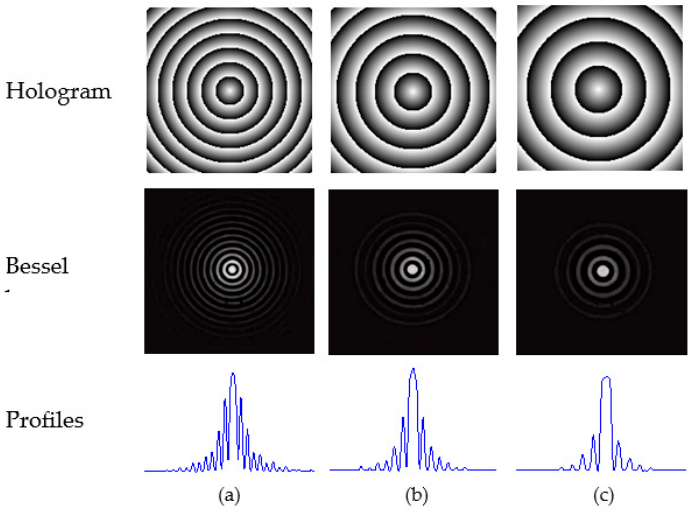
Figure 6. Bessel beams generated by the holograms with different periods: ( a ) d = 15, ( b ) d = 20, ( c ) d = 25 pixels.